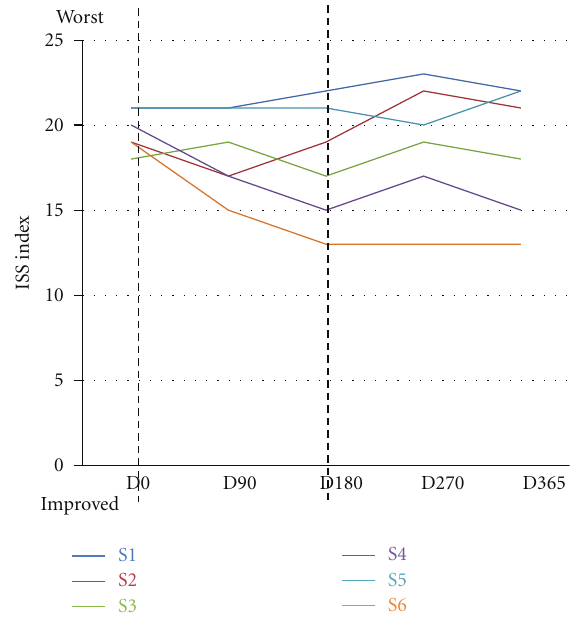
Figure 8: E ff ects of IGF1 treatment on International Severity Scale (ISS). The graph reports the clinical evaluation of the parameters of the International Severity Scale (ISS). D0 (first day of treatment, before IGF administration), D90 (90 days after the first IGF1 administration), D180 (180 days after the first IGF administration, last day of IGF1 treatment), D270 (270 days after first IGF administration), and D365 (365 days after first IGF administration). The dotted lines represent the start (D0) and the end (D180) of the treatment. Each patient is color-coded: S1: blue, S2: red, S3: green, S4: purple, S5: cyan, and S6: orange. At each visit the patients were evaluated and the score for the ISS annotated. An increase in the score shows a worsening of the conditions, while a decrease in the ISS score represents an improvement. During IGF treatment (D0–D180), half of the patients showed an improvement in the ISS score. Between D180 and D270, the ISS score increased for all the patients with the exception of S5 and S6. At D365, S6 and S4 had an improved ISS, score, while S3 had the same score as that at D0. S5, S2, and S1 had a higher ISS score at D365 than at D0. The improvement in ISS score is not significant considering the entire cohort of patients.